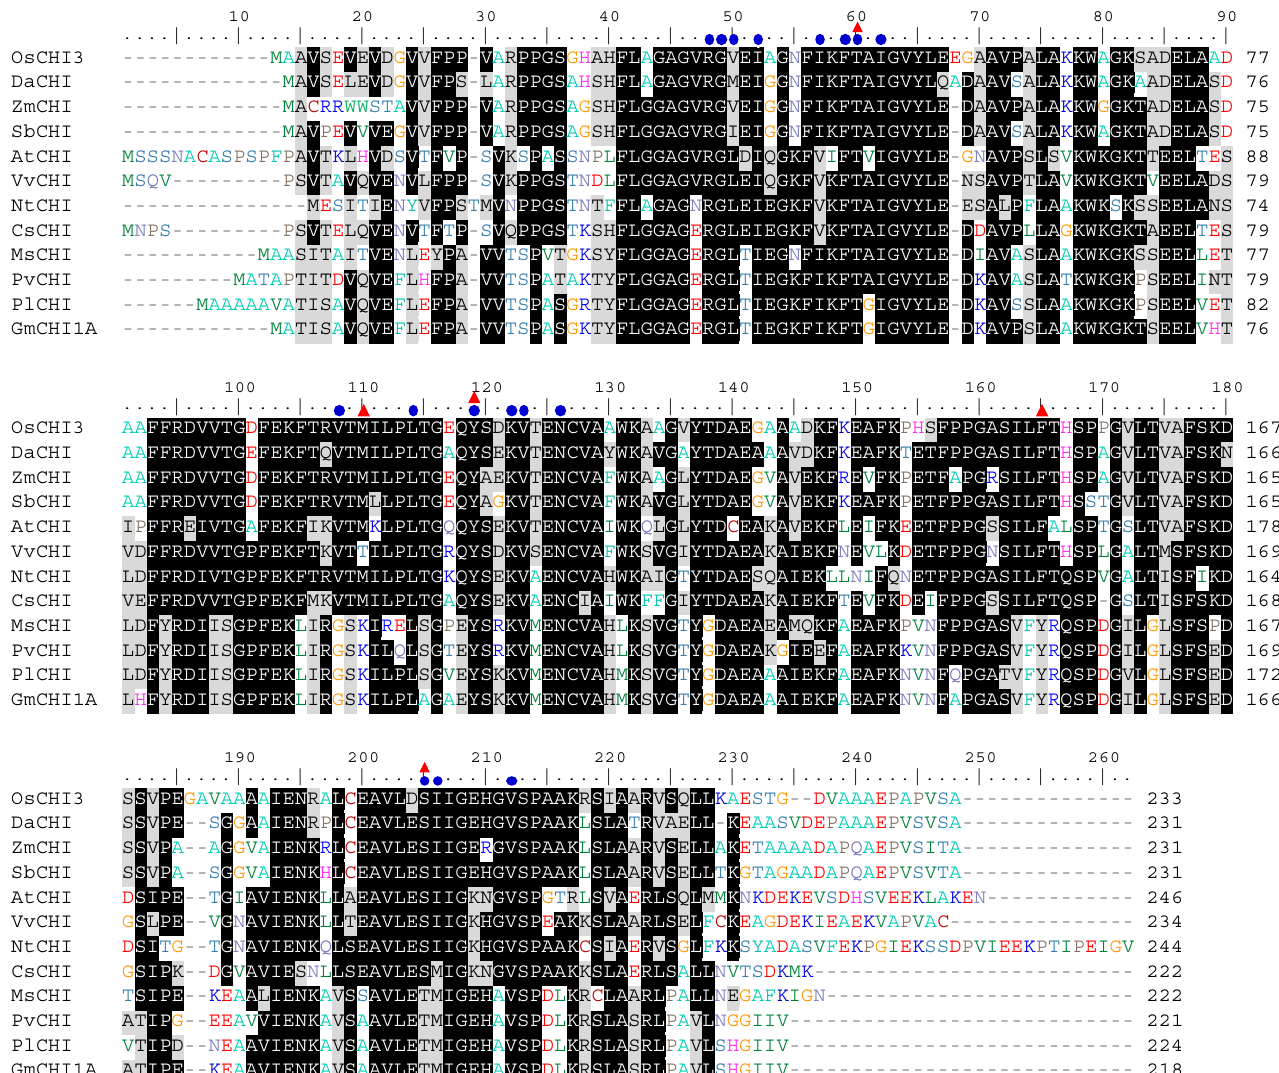
Figure 2. Multiple alignment of OsCHI3 with bona fide CHIs from other plant species. Identical and similar amino acid residues are shaded in black and grey, respectively. Blue circles above the residues indicate the conserved residues forming the substrate-binding cleft in MsCHI and DaCHI. Red triangles indicate the residues participating in the hydrogen-bond networks for catalysis.